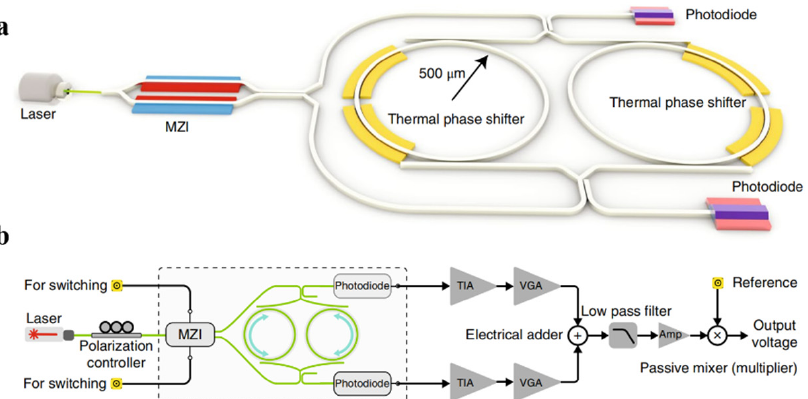
Figure 17. ( a ) Schematic of the implemented nanophotonic optical gyroscope. ( b ) System architecture with electronic circuitry. Signals from two paths are added together and multiplied by the reference frequency through a passive mixer to extract the amplitude information that encodes the rotation rate. TIA: transimpedance amplifier; VGA: variable gain amplifier; Amp: amplifier. Reprinted with permission from ref. [86]. Copyright 2018 Nature